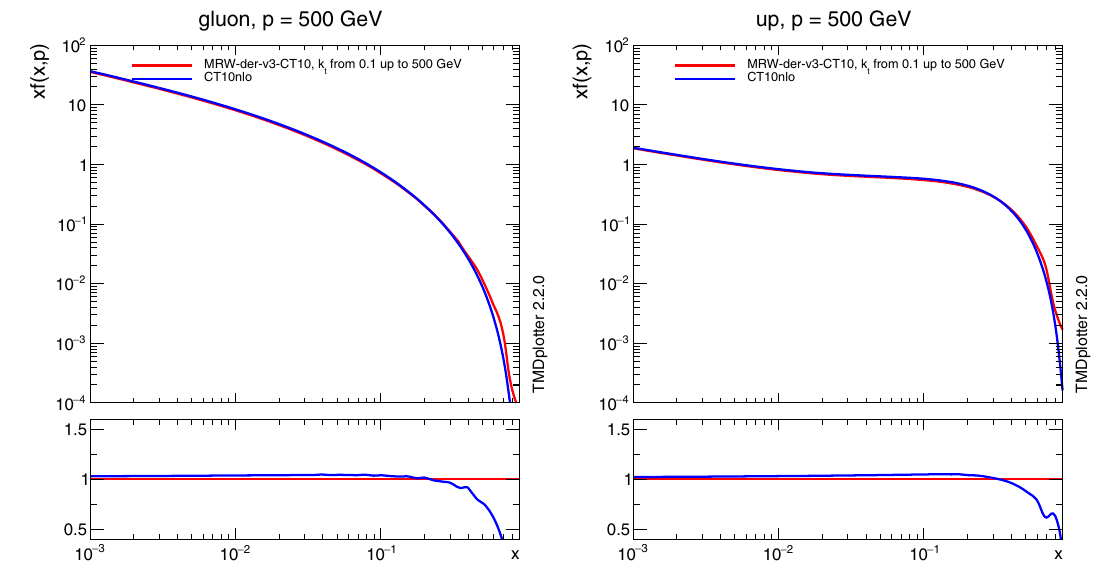
Fig. 1 Comparison between the integrated TMD using the method of Ref. [22] and the underlying collinear CT10nlo gluon PDFs [37] at a scale μ = 500 GeV for gluons (left) and u-quarks (right)